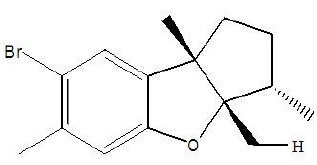
Figure 1. Chemical structure of aplysin.